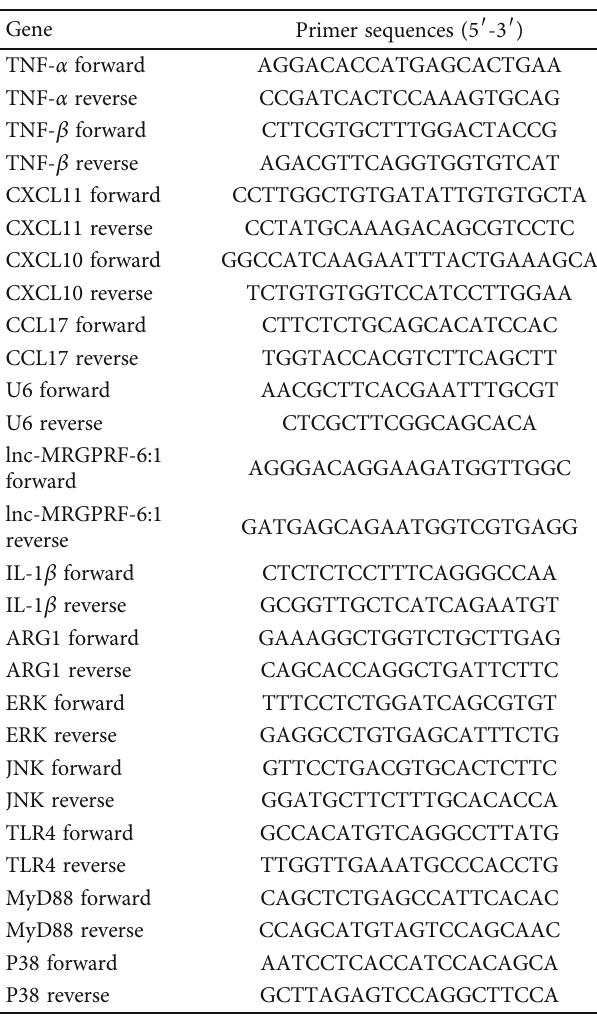
Table 1: The primer sequences in the present study.